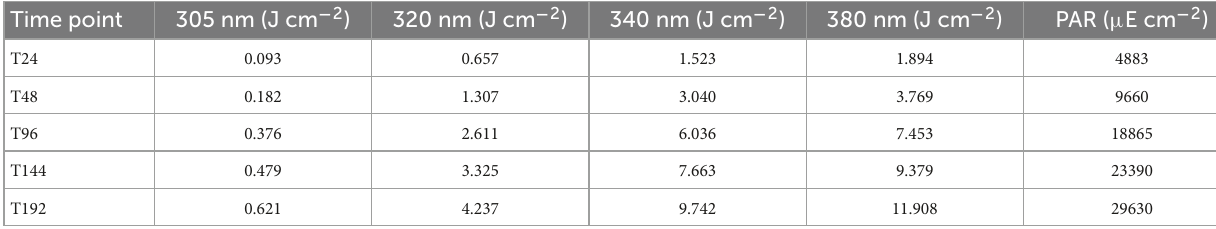
TABLE 4 Cumulative solar exposure for each WAF preparation time point in the duration of WAF solar exposure